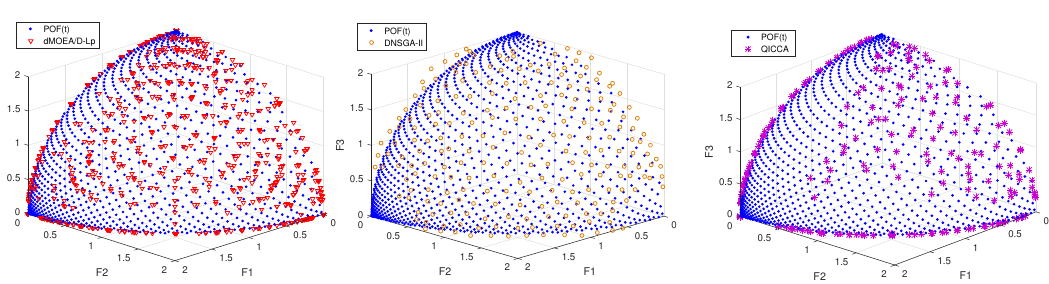
Figure 9. Solution sets obtained by three algorithms at t = 10.8 on FDA5 in case of τ T = 15, n T = 5.